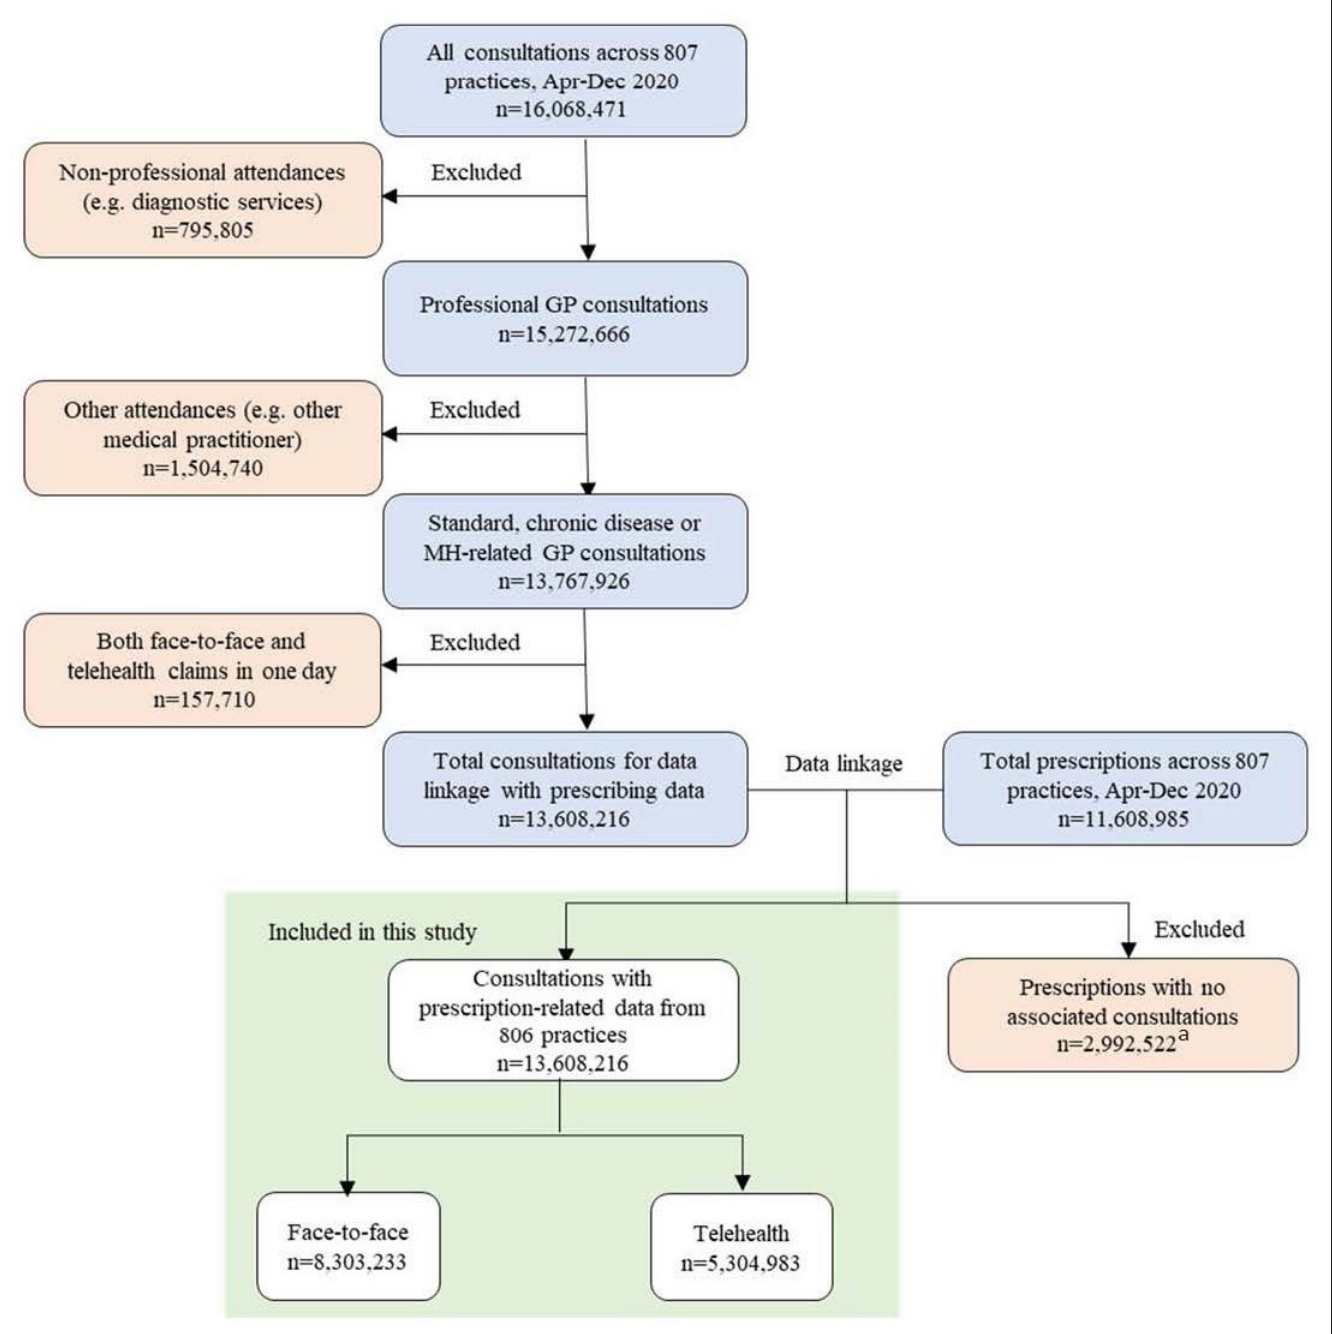
Figure 1 Participant selection flow chart, April–December 2020. a Indicates prescriptions not associated (linked) with the selected Medicare Benefit Scheme items for standard, chronic disease management, and mental health- related consultations. MH = mental